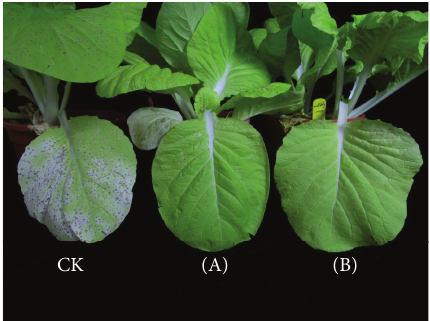
Figure 3: Effect of gallic acid (1000 𝜇 g/mL) (A) and methyl gallate (1000 𝜇 g/mL) (B) on control of anthracnose disease of Chinese cabbage caused by Colletotrichum higginsianum